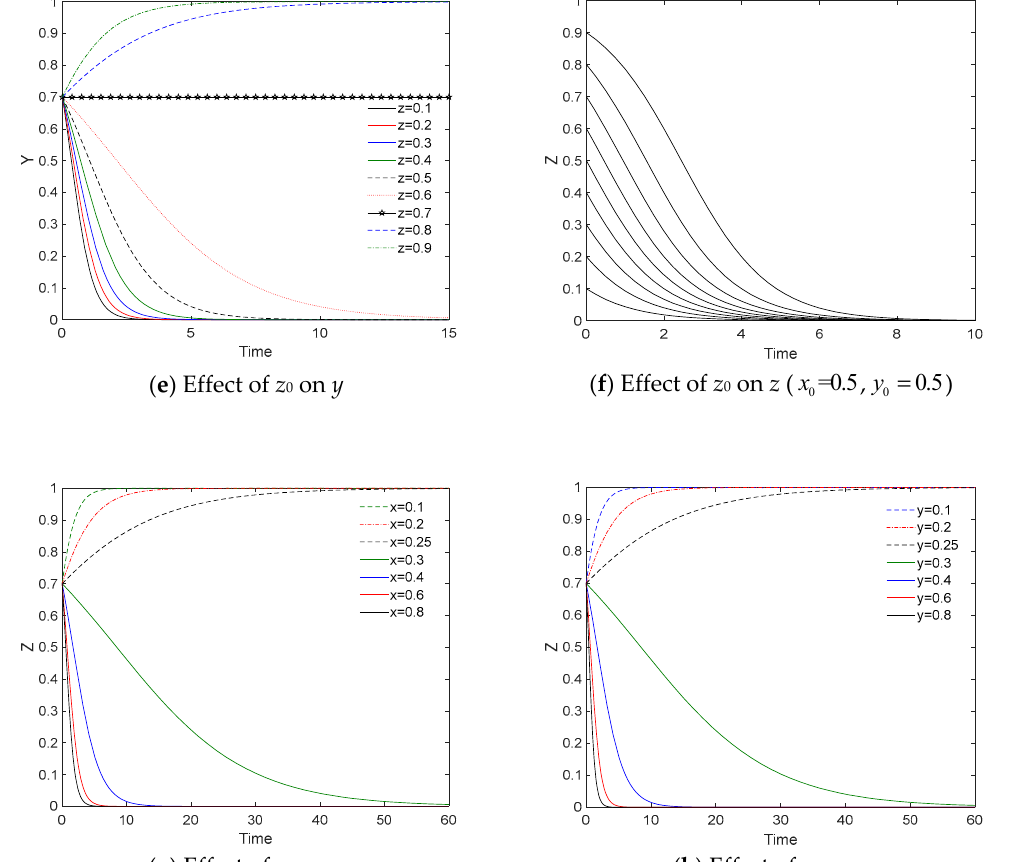
Figure 7. Effect of initial probability on the evolution process of suppliers, manufacturers and governments.